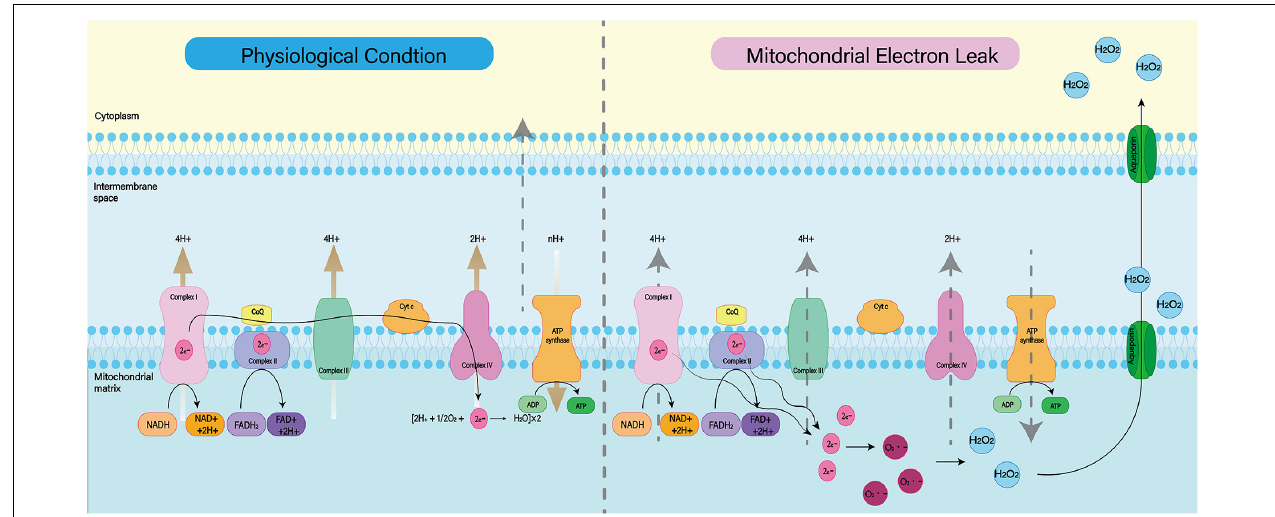
FIGURE 3 | Under normal physiological conditions, mitochondrial oxidative respiratory chain composed of complex I–IV can transfer electrons and H + and produce ATP together with ATP synthase. When complex I–IV is dysfunctional, electron leakage occurs. This leads to the production of ROS and H 2 O 2